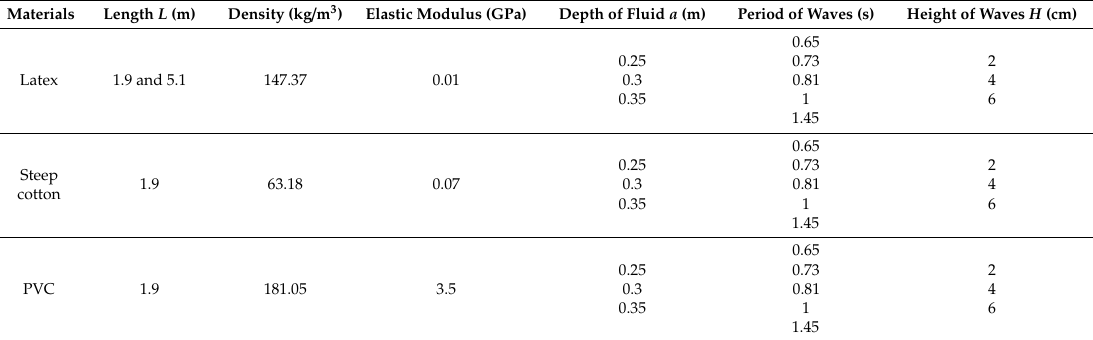
Table 1. Properties of elastic plates and generated waves.